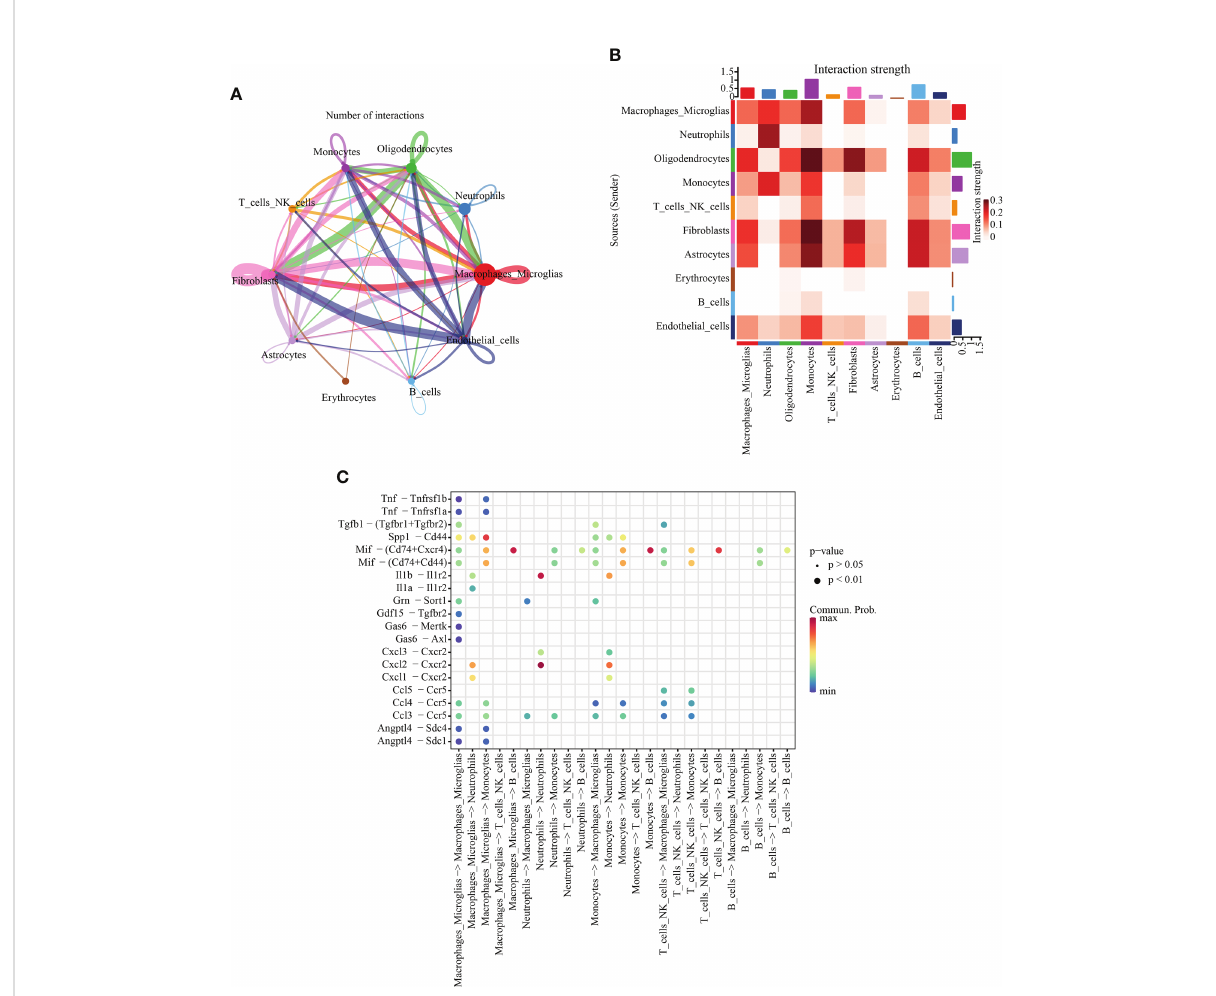
FIGURE 5 Intercellular communication analysis. (A) Quantitative network diagram in which the nodes represent different cell types, the arrows indicate the interaction signals from the ligand cell to the recipient cell, and the thickness of the line thickness indicates the number of signi fi cant ligand − receptor interaction pairs detected between different cell types. (B) Heatmap showing intercellular interaction intensity. The redder the color, the higher the proportion of interaction between ligand − receptor pairs. (C) The ligand − receptor pairs involved in intercellular communication between immune cells. The column represents the cell type of cellular communication (receptor cell ligand cell), the circle size indicates the signi fi cance level, and intensity of red color is directly proportional to the probability of communication between the interacting